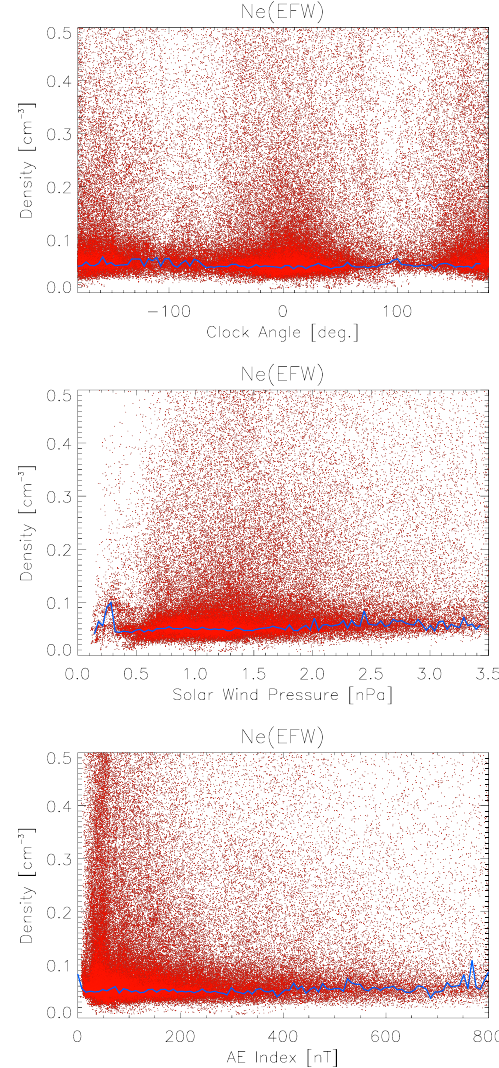
Fig. 4. This figure shows the electron density plotted as function of clock angle of the interplanetary magnetic field (top), the electron density plotted as function of solar wind pressure (middle) and the electron density plotted as function of the AE-index (bottom). Each plot also contains a blue line giving the most likely density mea- surement at each value of the free variable parameter in order to accommodate for any uneven distribution of density